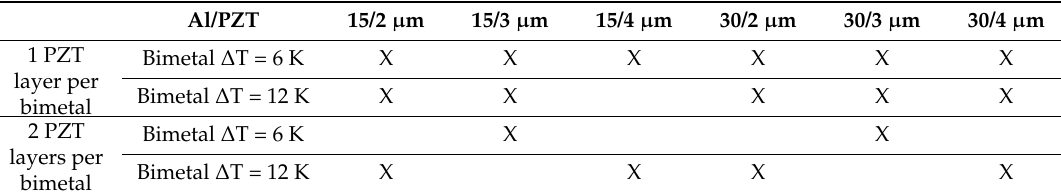
Table 1. Properties of the PZT thin films deposited onto the bimetals, T S = 70 °C for all bimetals.